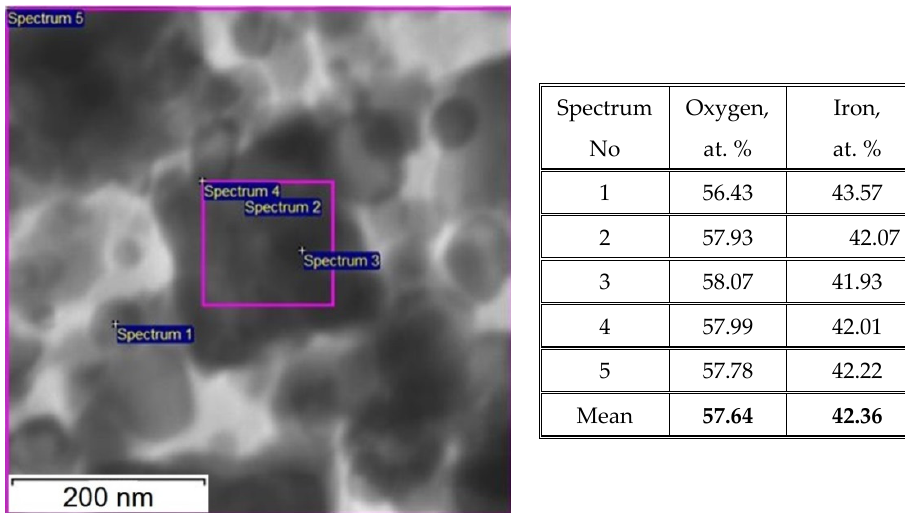
Figure 7. STEM image and Table with the EDS data on the oxygen and iron concentrations in dif- ferent points (2, 3) inside the pink square, in small spherical particle (1) and average over the pink square (4) and over the whole field of the Fe 3 O 4 @C@C NPs.